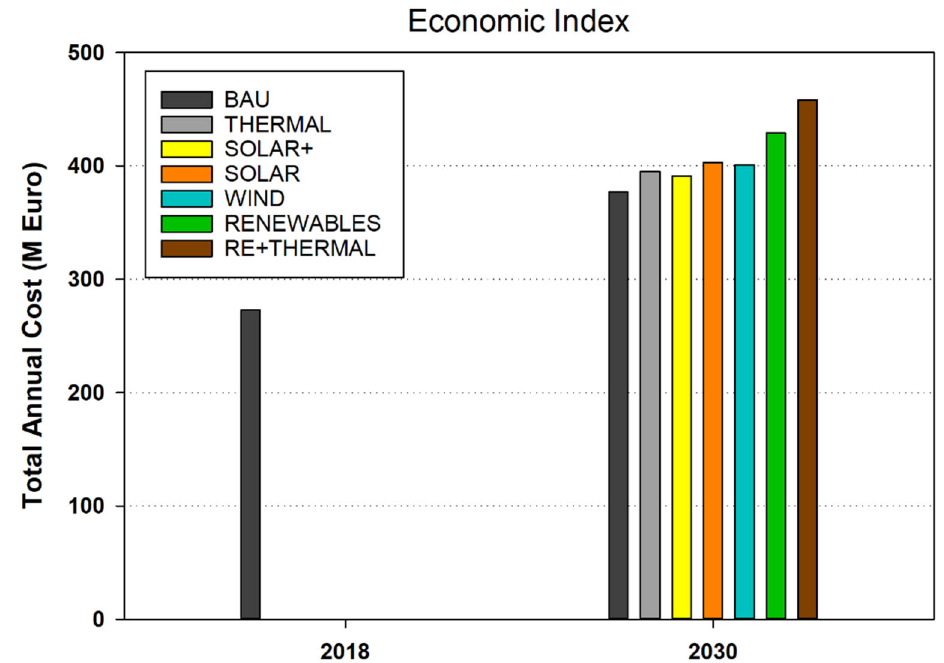
Figure 11. Total annual cost as economic index for base and forecast years.